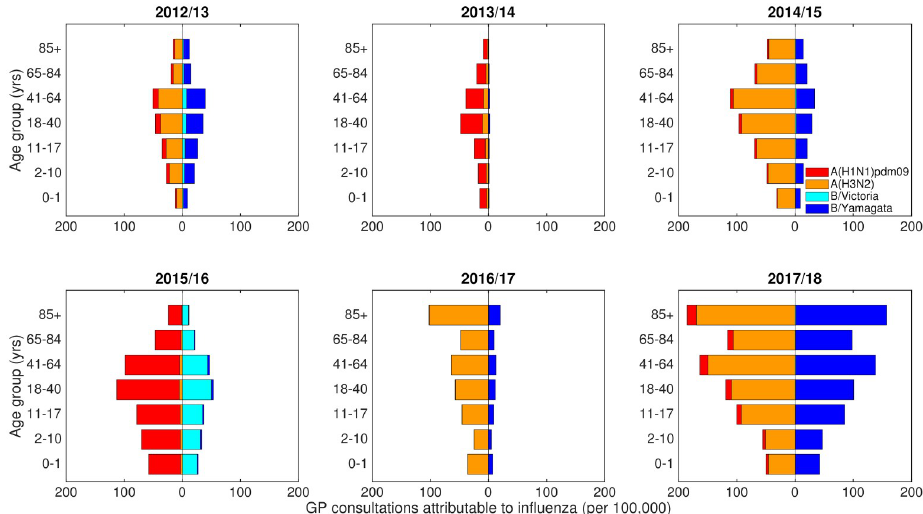
Fig 1. Empirical, age- and strain-stratified data for ILI GP consultations attributable to influenza per 100,000 population. The panels cover influenza seasons 2012/13 to 2017/18 (inclusive), the time span for which we performed parameter inference, with panel titles stating the respective influenza season displayed. In each panel, stacked horizontal bars in the left-half depict the cumulative total of ILI GP consultations attributable to type A influenza per 100,000 population per age group (red shading denoting the A(H1N1)pdm09 subtype, orange shading the A(H3N2) subtype). In the right-half of each panel stacked horizontal bars present similar data for type B influenza (cyan shading denoting the B/Victoria lineage, dark blue shading the B/Yamagata lineage). Note that rates were computed for each single year of age, with displayed bars per age group computed by averaging the individual rates over the specified age